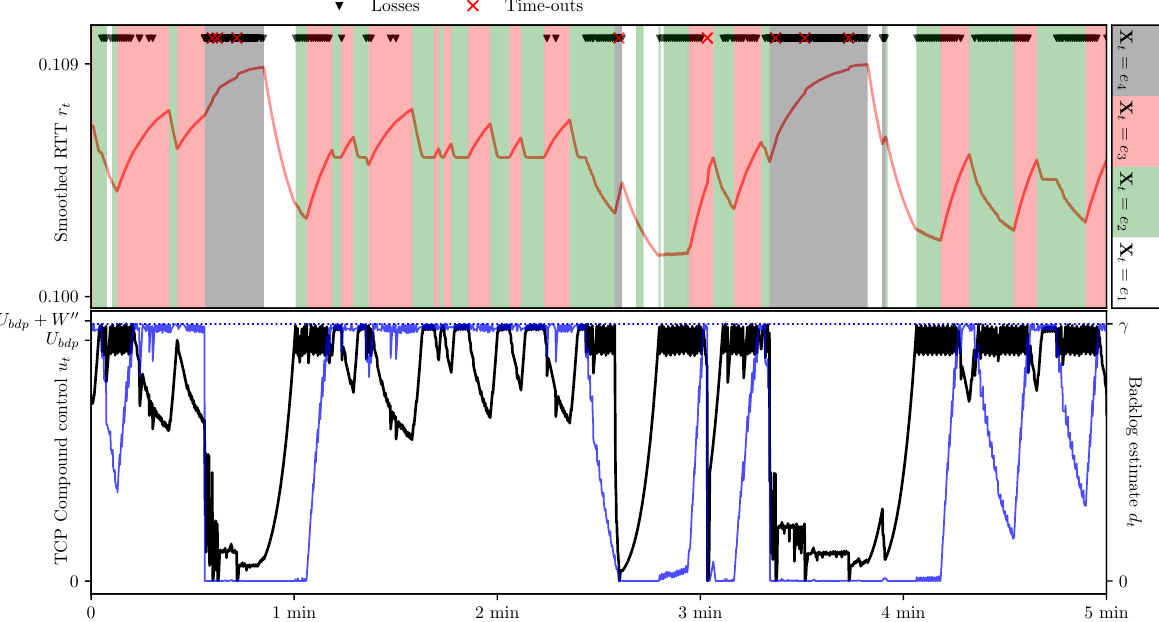
Figure 4. TCP channel simulation example for Compound control